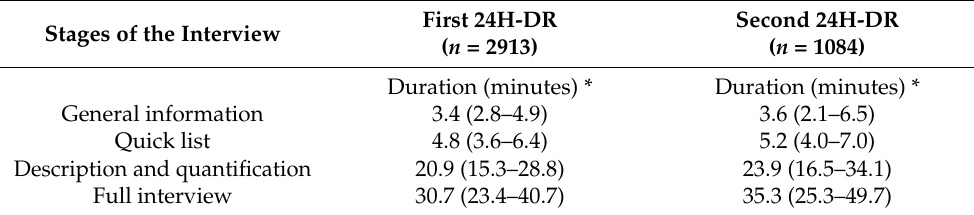
Table 4. Duration of the first (face-to-face) and the second (preferably by telephone) 24H-DR mea- surements amongst participants in the third wave of the ELSA-Brasil study in S ã o Paulo-SP. S ã o Paulo, 2019.